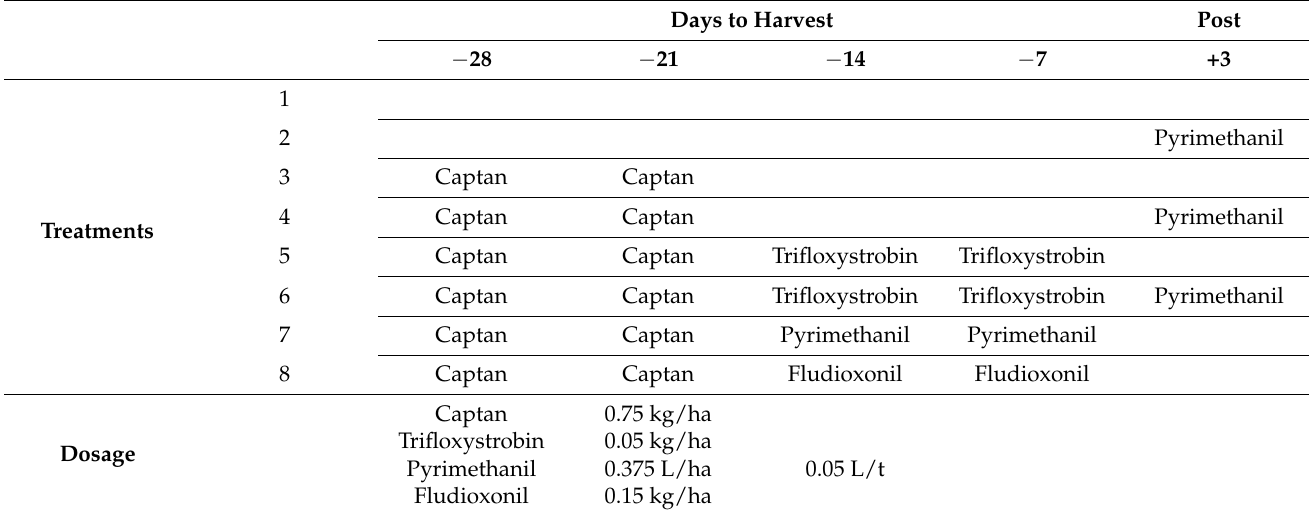
Table 2. Fungicide treatments, dosage, and time of